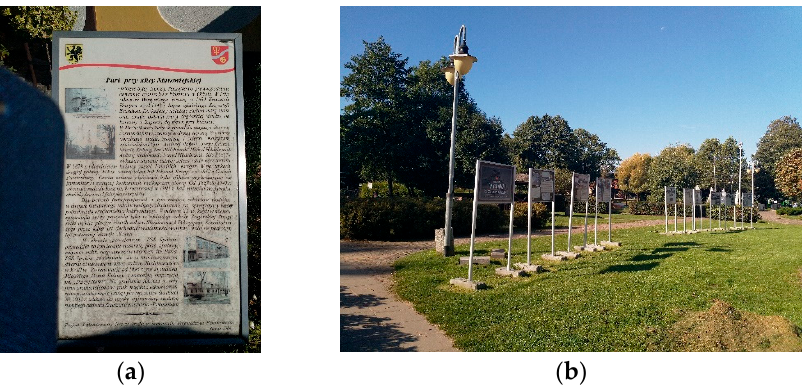
Figure 11. Educational tables in front of the manor house ( a ) permanent table with a short descrip- tion of the history of the park; ( b ) temporary exhibition dedicated to local history, source: author.